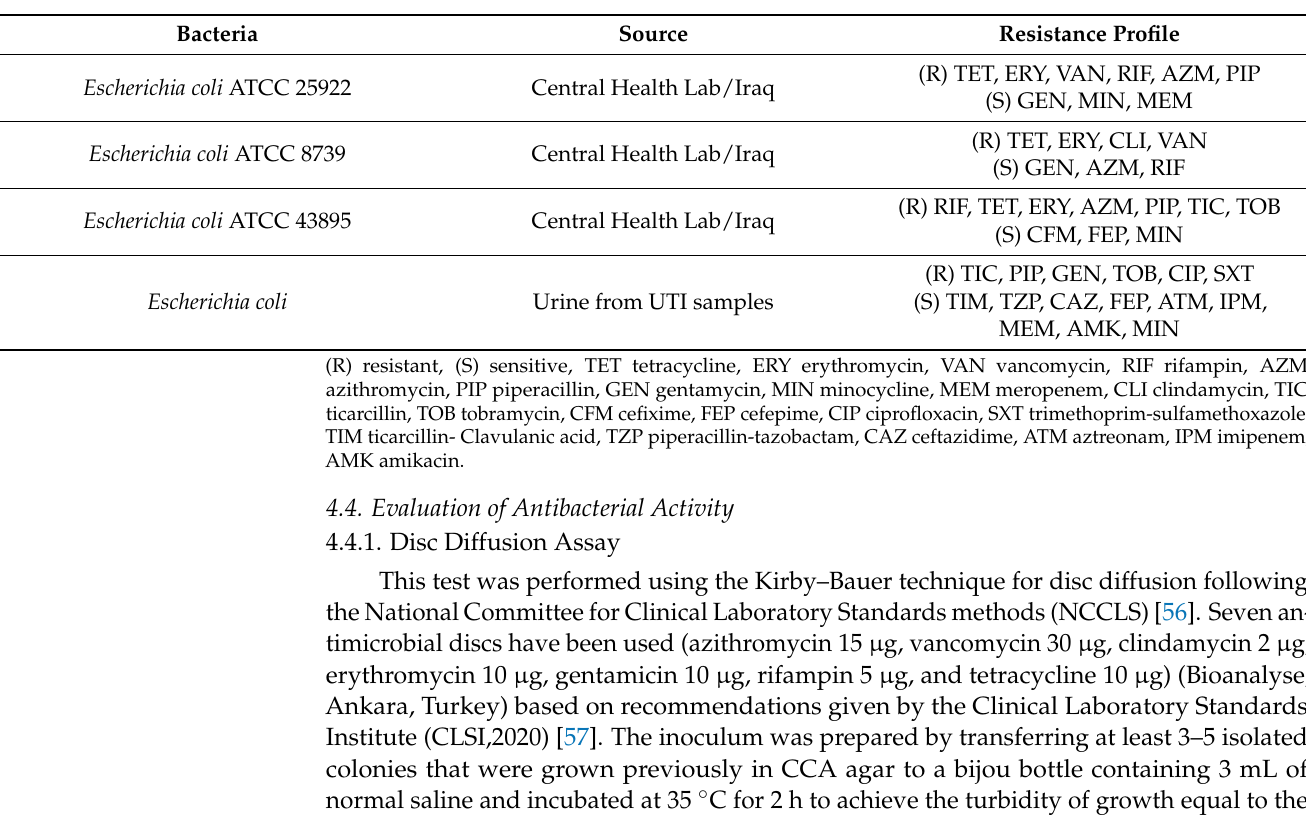
Table 5. Bacterial source and antibiotic resistance